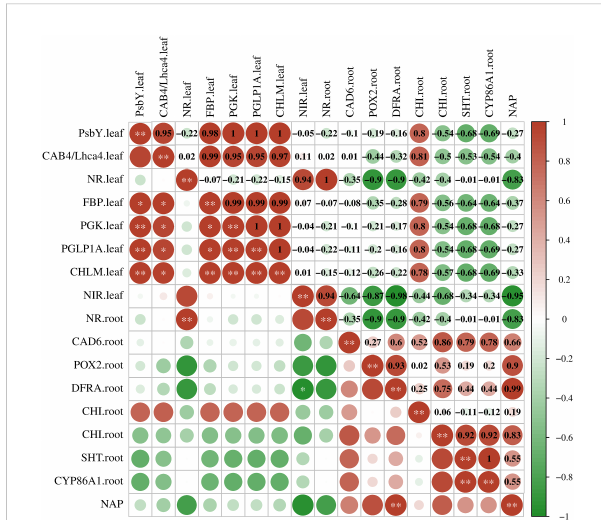
FIGURE 6 Pearson ’ s correlation coef fi cient (r) of the expression level of key genes. PSBY. leaf, photosystem II core complex proteins psbY, chloroplastic; CAB4/Lhca4. leaf, chlorophyll a – b binding protein 4; NR. leaf, nitrate reductase [NADH]; FBP. leaf, fructose 1,6- bisphosphatase, cytosolic; PGK. leaf, phosphoglycerate kinase, chloroplastic; PGLP1A. leaf, phosphoglycolate phosphatase 1A; CHLM. leaf, magnesium protoporphyrin IX methyltransferase; NIR. leaf, ferredoxin-nitrite reductase; CAD6. root, probable cinnamyl alcohol dehydrogenase 6; POX2. root, proline dehydrogenase 2, mitochondrial; DFRA. root, dihydro fl avonol 4-reductase; CHI. root, chalcone- fl avanone isomerase; SHT. root, spermidine hydroxycinnamoyl transferase; CYP86A1. root, cytochrome P450 86A1; NAP, nitrogen accumulation in plants. Scale: bright blue to bright red represents negative to positive correlations. *p < 0.05, **p <